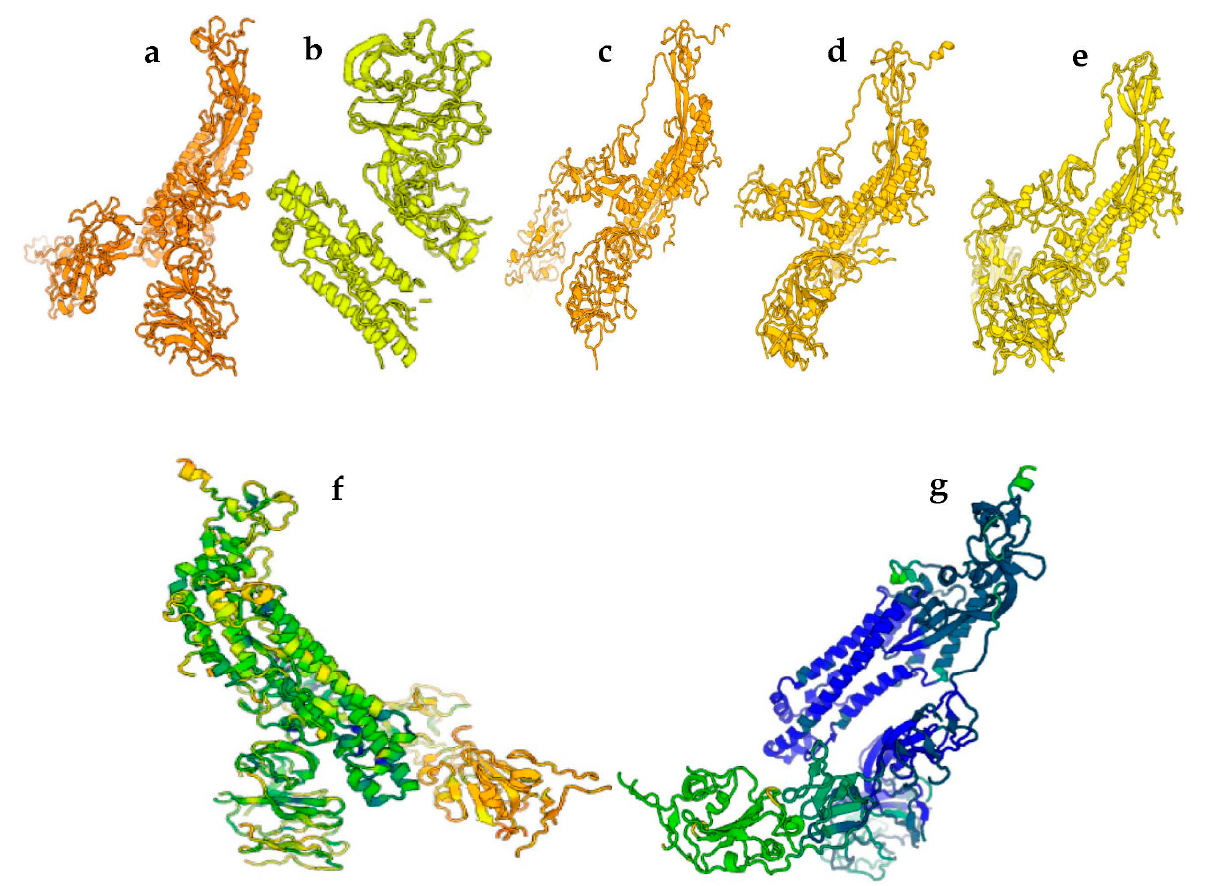
Figure 4. Ribbons structures of ( a ) 7CN8, ( b ) 7QO7, ( c ) 6CS2, ( d ) 6NZK, ( e ) 6JX7 and ( f , g ) sequence and structural conservations mapped onto the query structure. The color map for conservation mapping in DALI spans from blue (which shows the highest values) through green to red (which shows the lowest values). ( f , g ) Sequence and structural conservation of the five structures against the query structure, respectively. Blue color regions in ( f , g ) show high sequence and structural similarities in five structures. The green color in ( f ), which can be seen frequently, shows fewer similarities and the yellow color shows more dissimilarities. The green color in ( g ) represents strands of barrel that have reversed the direction in some structures. The A chains of all structures are used in comparison against the query structure.